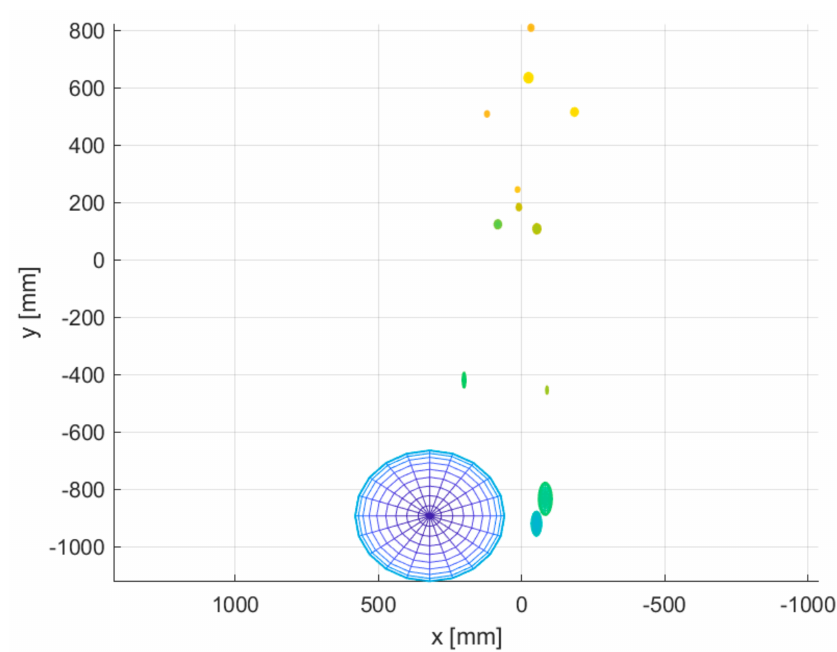
Figure 20. Body joint noise of Kinect v1 with skeleton smoothing turned